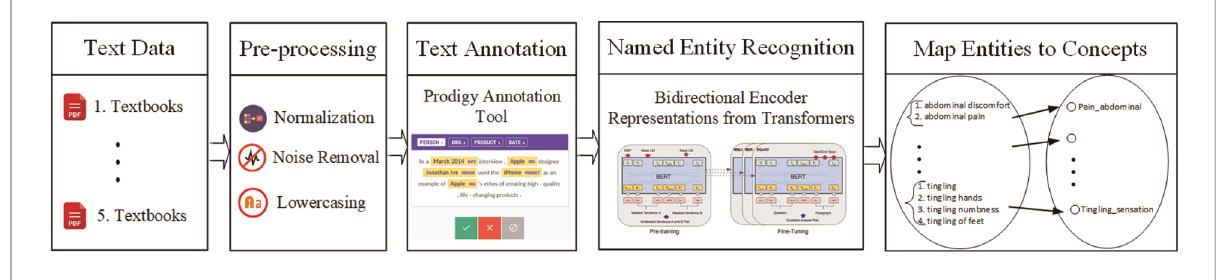
FIGURE 1 Overview of the pipeline that recognizes text spans that are clinical concepts in three corpora: Textbook neurology case histories, EHR physician notes, and Clinical synopses in the OMIM. Text spans are normalized by mapping to clinical concepts in a